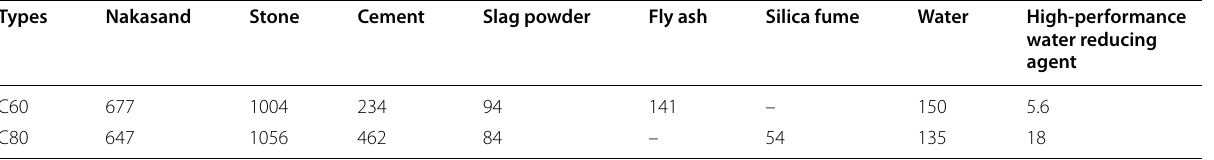
Table 2 Design of high-strength concrete ratio (m 3 /kg).